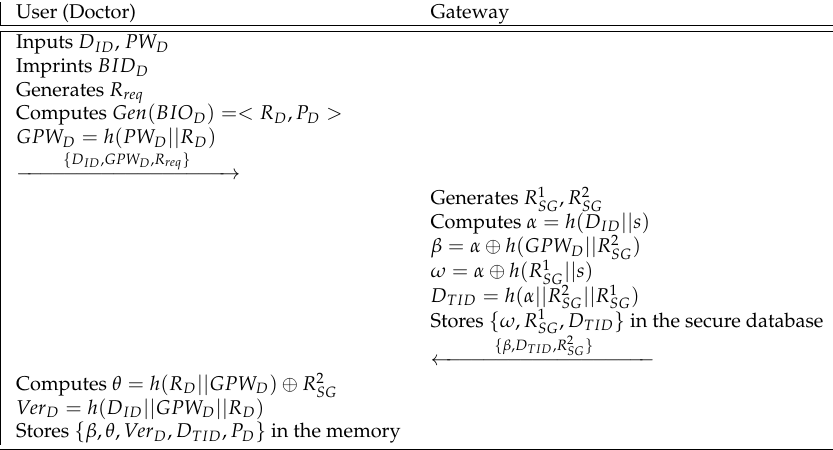
Figure 4. User registration phase of the proposed scheme.